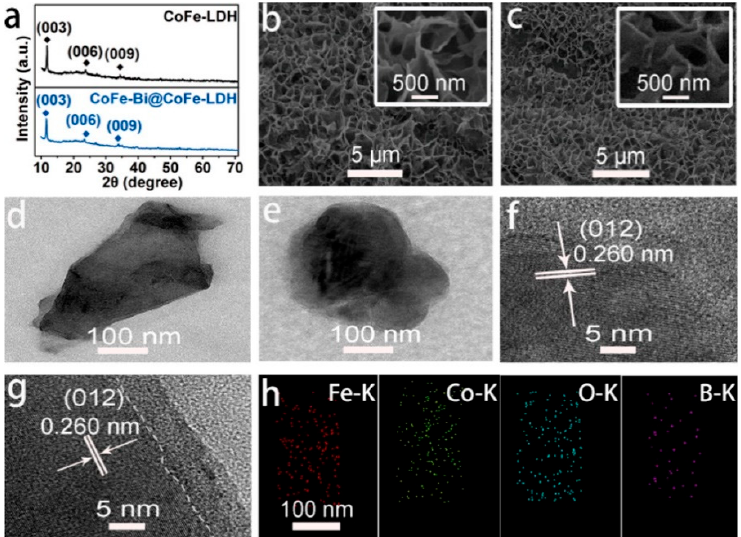
Figure 9 . Structural and morphological characterization of CoFe ‐ LDH and CoFe ‐ B i @CoFe ‐ LDH: ( a ) Figure 9. Structural and morphological characterization of CoFe-LDH and CoFe-B i @CoFe-LDH: XRD patterns, SEM images of ( b ) CoFe ‐ LDH NA/TM and ( c ) CoFe ‐ B i @CoFe ‐ LDH NA/TM. TEM ( a ) XRD patterns, SEM images of ( b ) CoFe-LDH NA/TM and ( c ) CoFe-B i @CoFe-LDH NA/TM. images of ( d ) CoFe ‐ LDH, and ( e ) CoFe ‐ B i @CoFe ‐ LDH. HRTEM images of ( f ) CoFe ‐ LDH and ( g ) CoFe ‐ TEM images of ( d ) CoFe-LDH, and ( e ) CoFe-B i @CoFe-LDH. HRTEM images of ( f ) CoFe-LDH and B i @CoFe ‐ LDH. ( h ) Elemental mapping images of CoFe ‐ B i @CoFe ‐ LDH. Reproduced from [31], with ( g ) CoFe-B i @CoFe-LDH. ( h ) Elemental mapping images of CoFe-B i @CoFe-LDH. Reproduced from